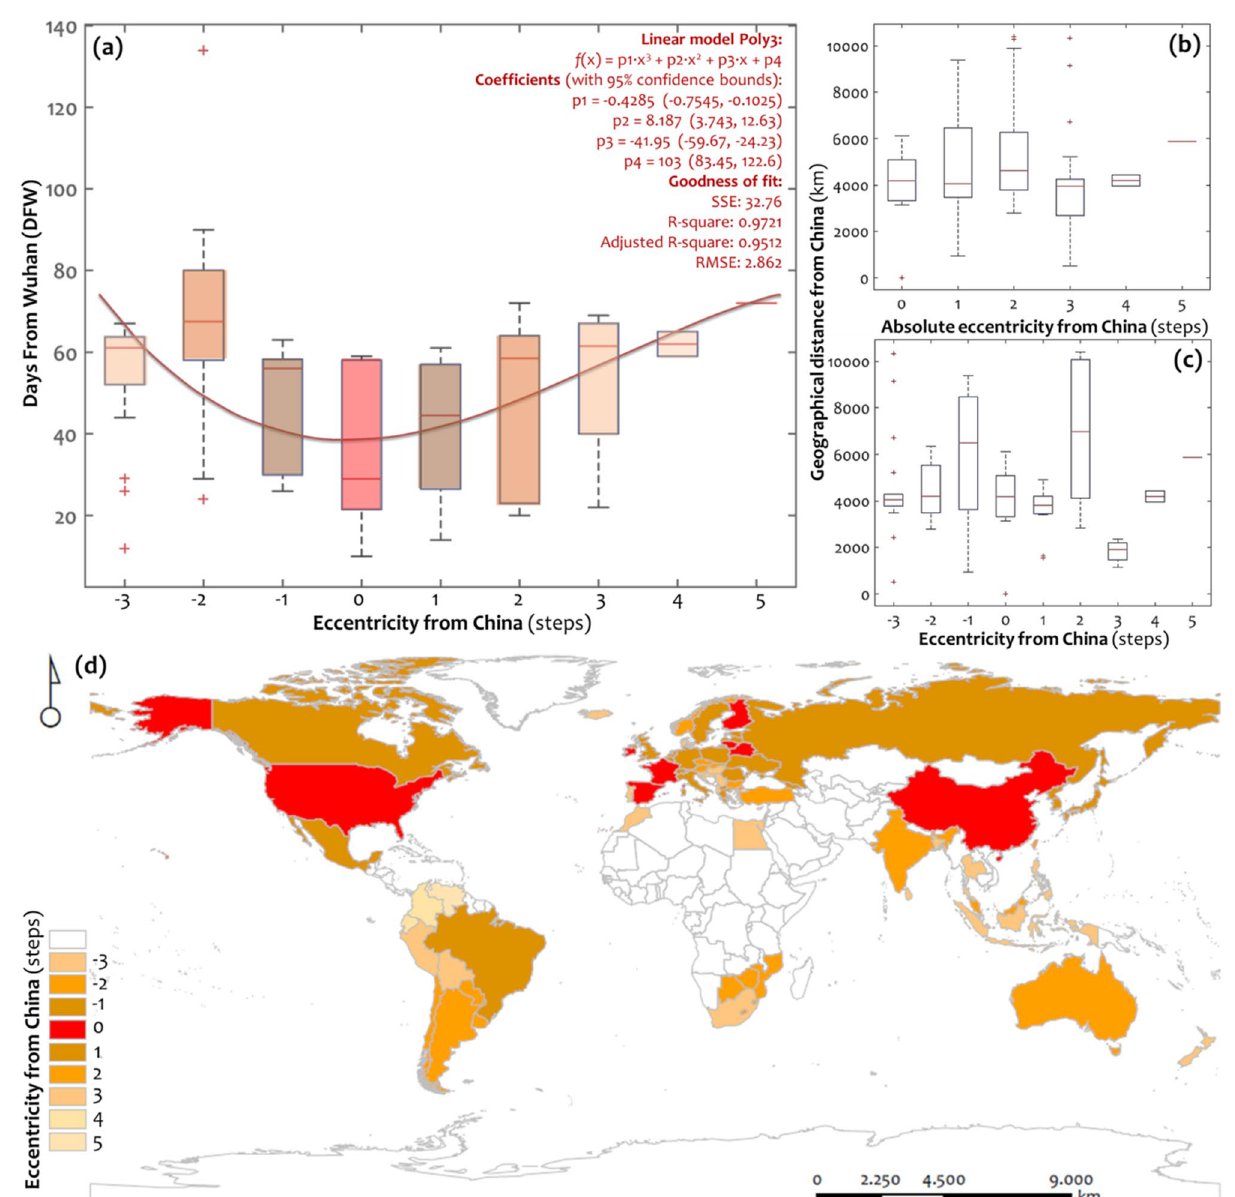
Figure 5. Boxplots expressing ( a ) the days since the first infection from Wuhan (DFW) for each class of the GTN’s eccentricity centered at China (abbreviated: eccentricity from China), the eccentricity of which is 3 steps (also shows the fitting curve of best determination applied to average values), and the geographical distance from Wuhan (DFW) for each class of ( b ) absolute and ( c ) non-absolute eccentricity from China. Also, the diagram shows the fitting curve of best determination applied to the average values. The bottom map ( d ) shows the spatial distribution of the eccentricity from China (maps are own elaboration based on ESRI ArcGIS 10.50; https:// www. arcgis.